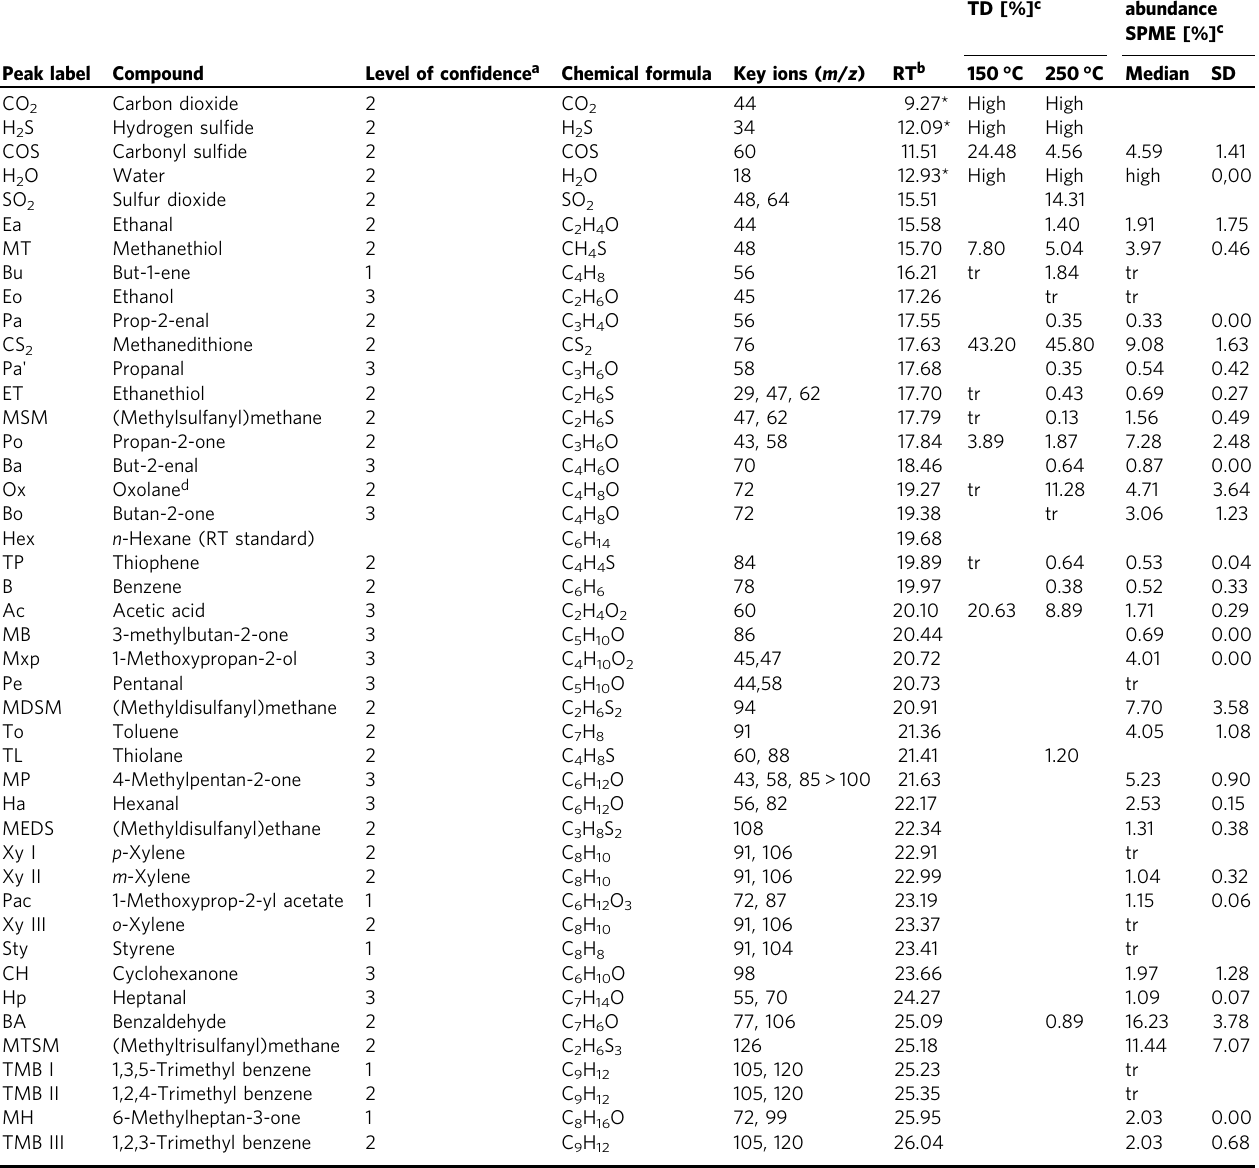
Rel. abundance Rel. TD [%] c